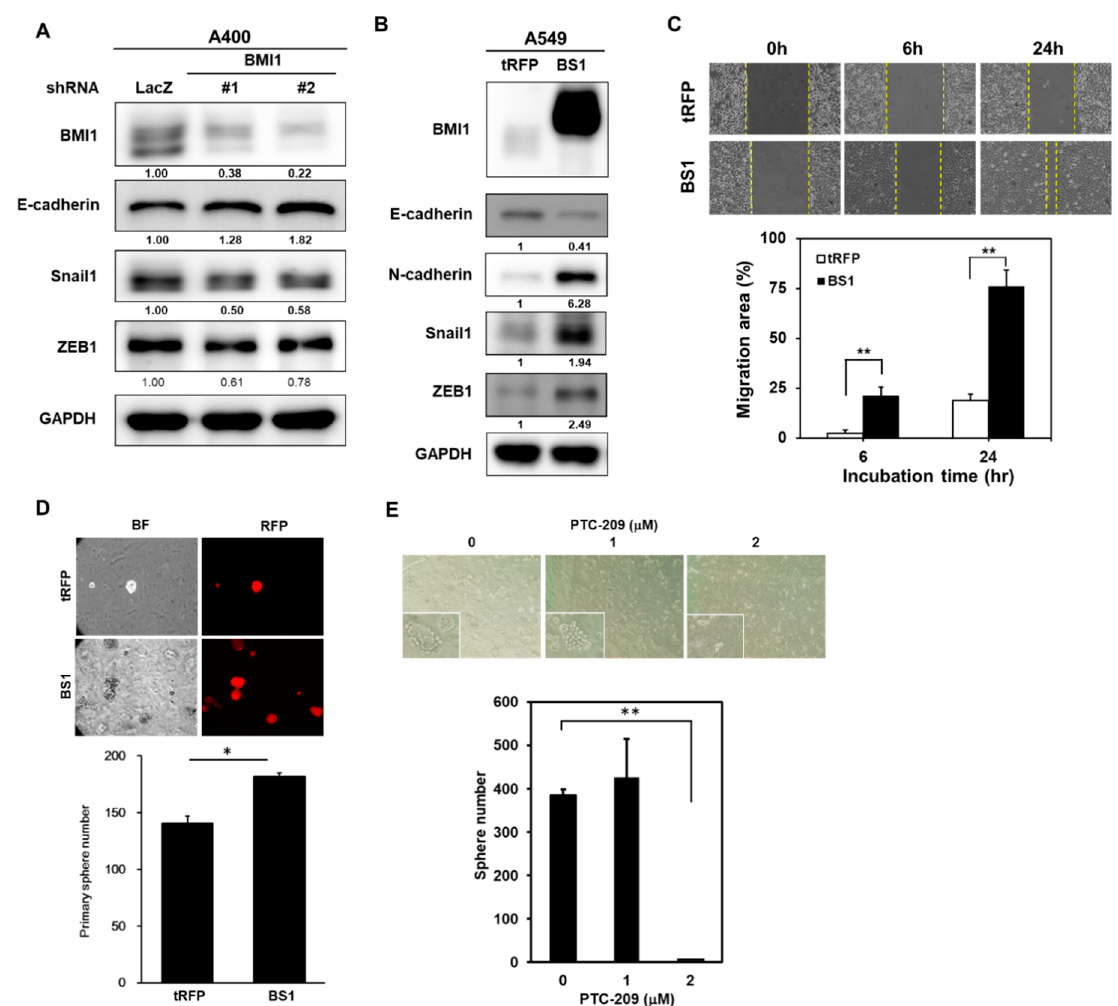
Figure 6. Overexpression of BMI1 induces EMT in A549 NSCLC cells. ( A ) A400 cells were transduced with lentiviruses carrying shLacZ, shBMI1#1, or shBMI1#2, respectively, for 72 h and the total cellular proteins were collected for western blot analysis of BMI1 or the EMT-related molecules including E-cadherin / Snail1 / ZEB1. GAPDH was used as a protein loading control. ( B – D ) A549 cells were transduced with lentiviruses of tRPF control (A549-tRFP) or flag-tagged-BMI1 (A549-BS1) and selected with 20 µ g / mL blasticidin S for 96 h. The protein expressions of BMI1 and the EMT markers including E-cadherin / N-cadherin / Snail1 / ZEB1 were determined by western blot ( B ). Cell migration abilities of A549-tRFP or A549-BS1 cells were analyzed by wound healing assay ( C ). ** p < 0.01. The CSC activity of A549-tRFP or A549-BS1 cells were assessed by tumorsphere cultivation ( D ). The red fluorescent protein (RFP) signals (upper panel) and tumorsphere numbers (lower panel) were captured and counted with an inverted fluorescence microscopy at Day 14. * p < 0.05. ( E ) Tumorsphere cultivation was performed on A400 cells in the presence of 1 or 2 µ M PTC-209 and the formed tumorspheres were pictured (upper panel) and counted (lower panel) at Day 14. ** p < 0.01 as compared to DMSO control. All the experiments were done two times and data from one experiment were presented.